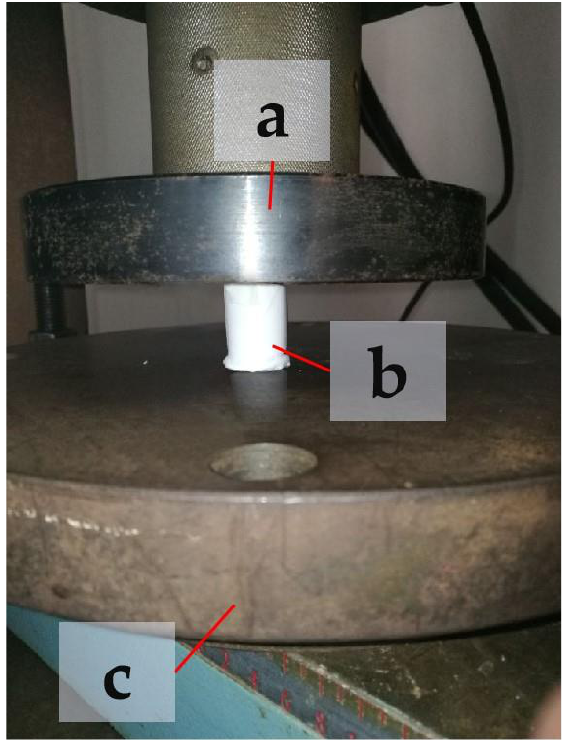
Figure 4. Compression head: ( a ) upper plate; ( b ) experimental component; ( c ) lower plate.